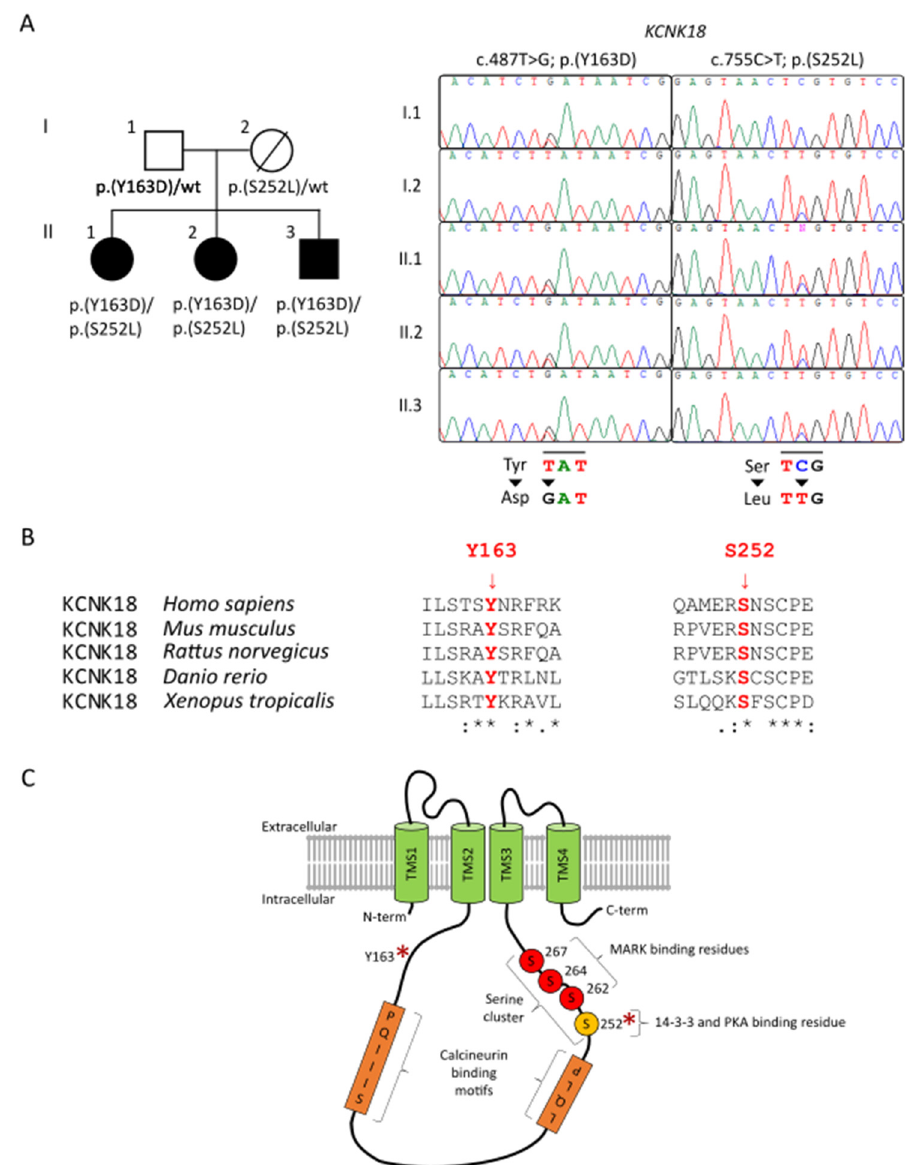
Figure 1. Pedigree, conservation, and graphical representation of the KCNK18 variants. ( A ). Pedigree of the family and Sanger sequencing chromatograms documenting co-segregation between compound heterozygosity for the two missense changes in KCNK18 and clinical traits transmitted in the family. ( B ). Multiple alignments of the amino acid stretches flanking the affected residues in TRESK orthologs showing conservation of both mutated residues (in red). Residues are referred to human KCNK18, NM_181840.1. ( C ). Schematic topology of the human K2P TRESK channel, showing location of Tyr163 (Y163) and Ser252 (S252) (red asterisks). Human TRESK is composed of 384 amino acid residues and shows the most characteristic features of K2P channels, including four transmembrane helices, two pore-forming domains, and intracellular N- and C-termini. A peculiar structural feature of TRESK (compared to other K2P channels) is the long intracellular loop between the second and third transmembrane segments (TMS), and the relatively short C-terminal tail [3]. In the image, representative domains are shown: PQIIIS and LQLP are calcineurin-binding motifs [5,17], while the serine cluster and Ser252 are indicated by the letter S and are, respectively, MARK kinases and 14-3-3 and PKA binding motifs.